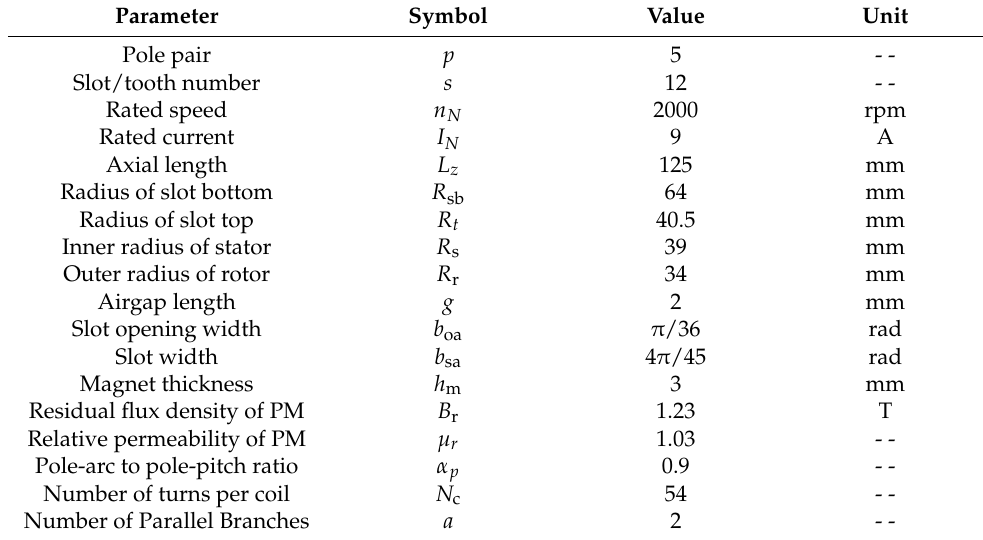
Table 1. Main parameters of PM motor.